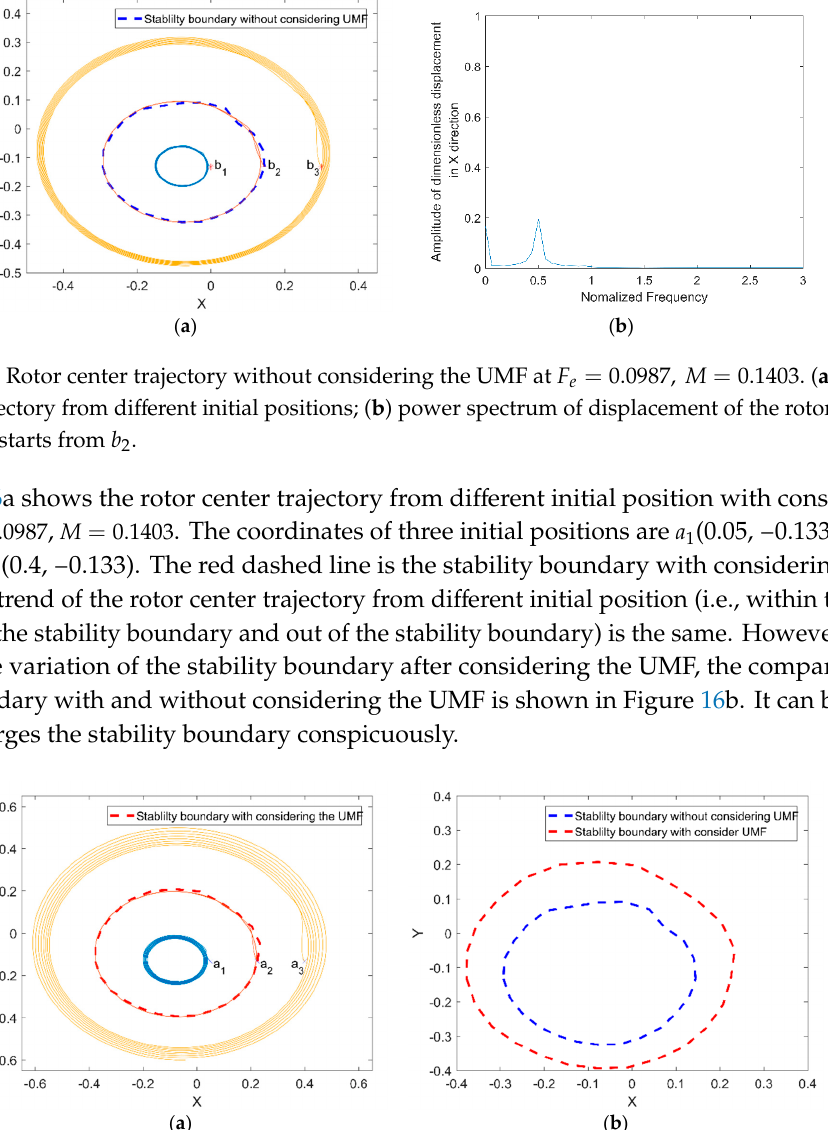
Figure 16. Rotor center trajectory with considering the UMF at 𝐹 (cid:3032) = 0.0987,𝑀 = 0.1403. ( a ) Rotor center trajectory from different initial position; ( b ) comparison of stability boundary with and without considering the UMF.